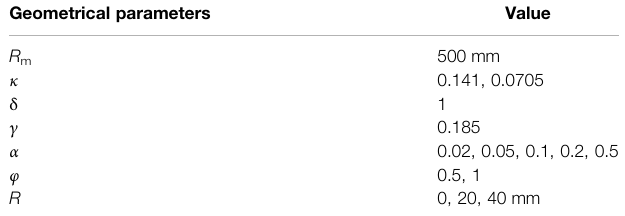
TABLE 1 | Geometrical parameters of the model. Geometrical